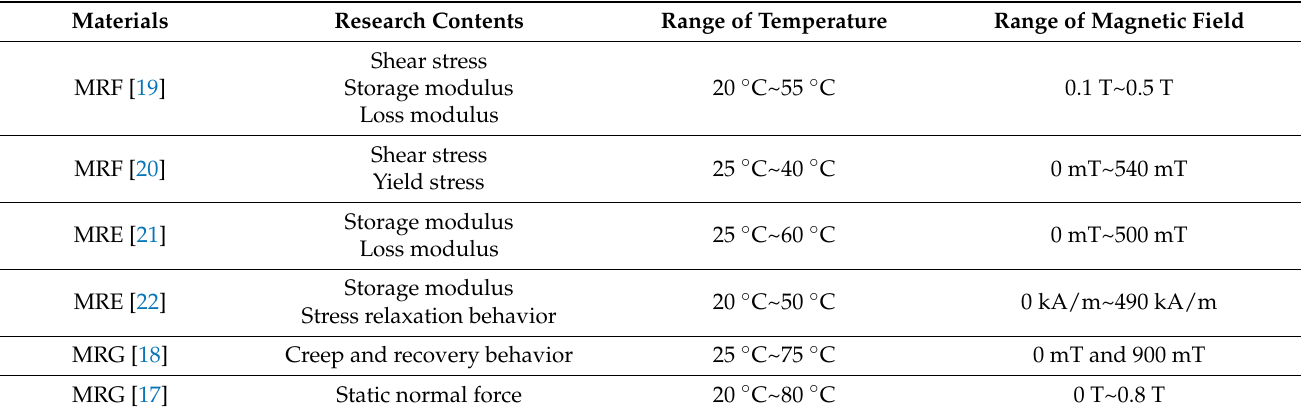
Table 1. References that studied the influence of temperature on rheological properties of MR